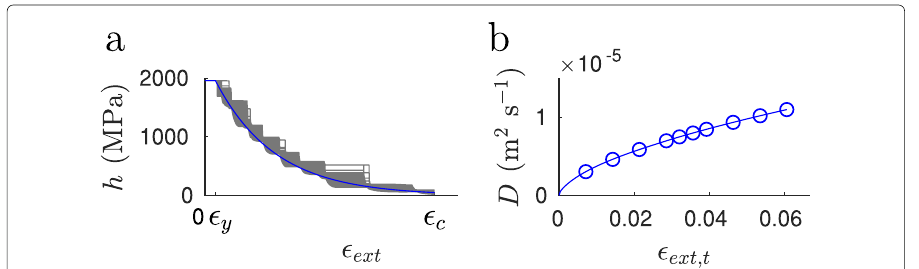
Fig.2 a The strain evolution of the expected average hardening coefficient (cid:4) h (cid:5) (blue) and the local hardening parameter values from one simulation (grey). The drops in the local hardening coefficient signify increases in the local plastic strain due to passing of bands. b The strain rate dependence of the parameter D = D 0 (cid:2) γ ext ,